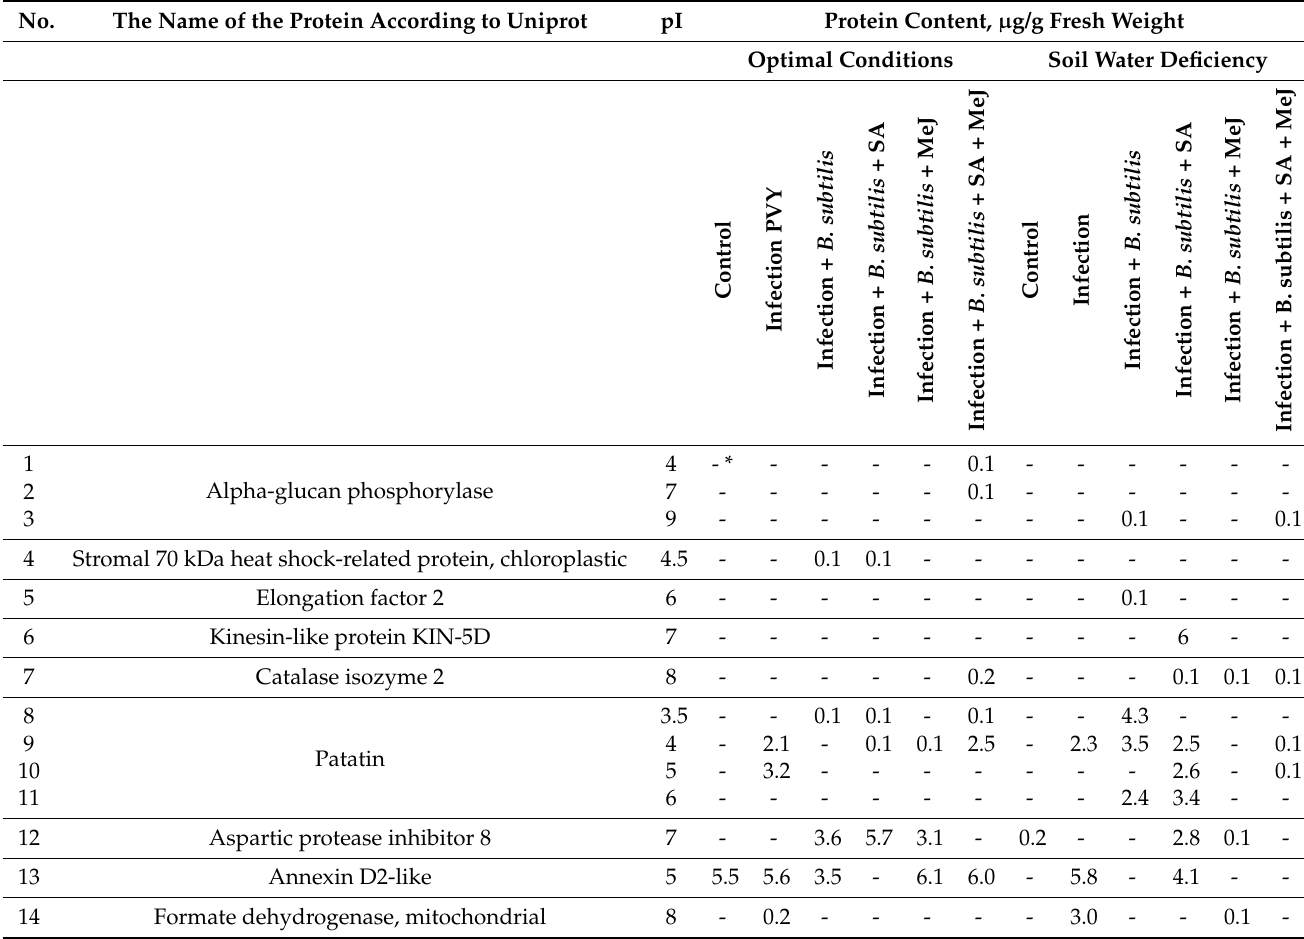
Table 3. Effect of PVY infection and mixture of B. subtilis with SA and MeJ application in optimal conditions and under soil water deficiency on different proteins content in mini-tubers.